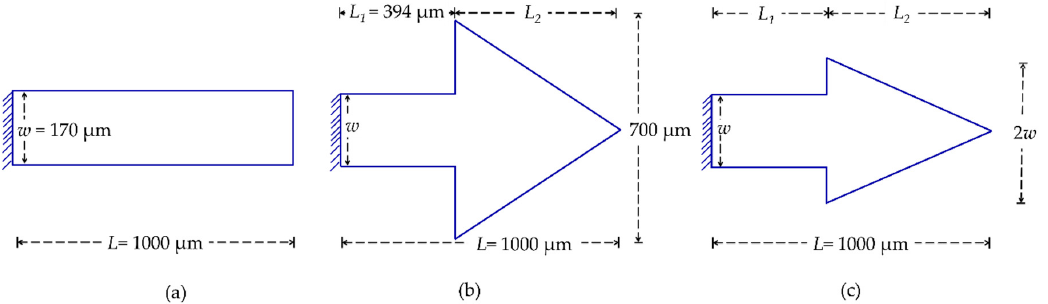
Figure 3. Schematic designs of ( a ) Rectangular (regular) cantilever (RCant1), and triangular cantilevers ( b ) first type (TCant1) and ( c ) second type (TCant2). The shape of the triangular free-end of TCant1